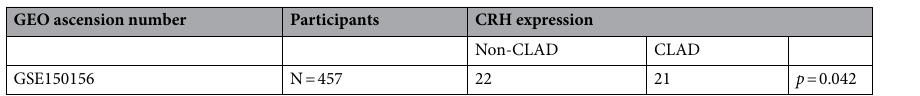
Table 2. Validation through external microarray data. Values are expressed as quantile normalized intensity. CLAD, chronic lung allograft dysfunction; CRH, corticotropin releasing hormone; GEO, gene expression